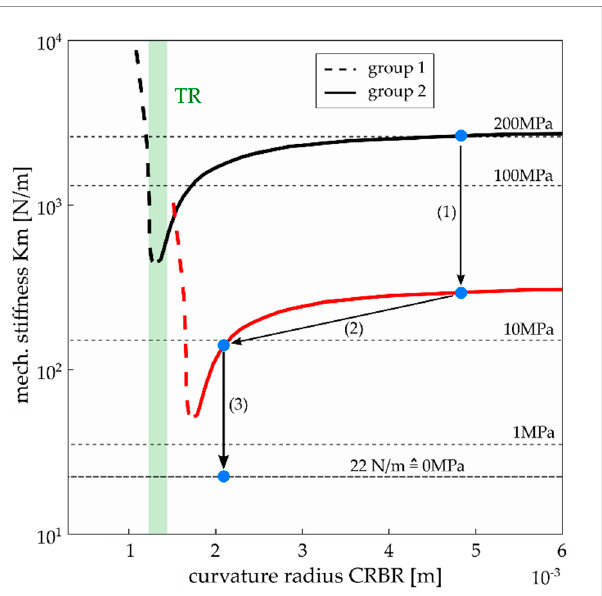
Figure 13. A possible strategy for the fabrication of stress-free diaphragms illustrated in a Km-CRBR plot: (1) Ti/Pt multi-layer coating optimized for low stress and high mechanical strength; (2) stress relief mechanism as a result of the adjustment of an optimum diaphragm surface shape before it is released from the SM; (3) thermal annealing. Remark: The stress values are valid for a diaphragm with 0.6 mm diameter and 1 μ m thickness and made from an H2 coating. For zero intrinsic stress, the diaphragm exhibits a stiffness of 22 N/m.